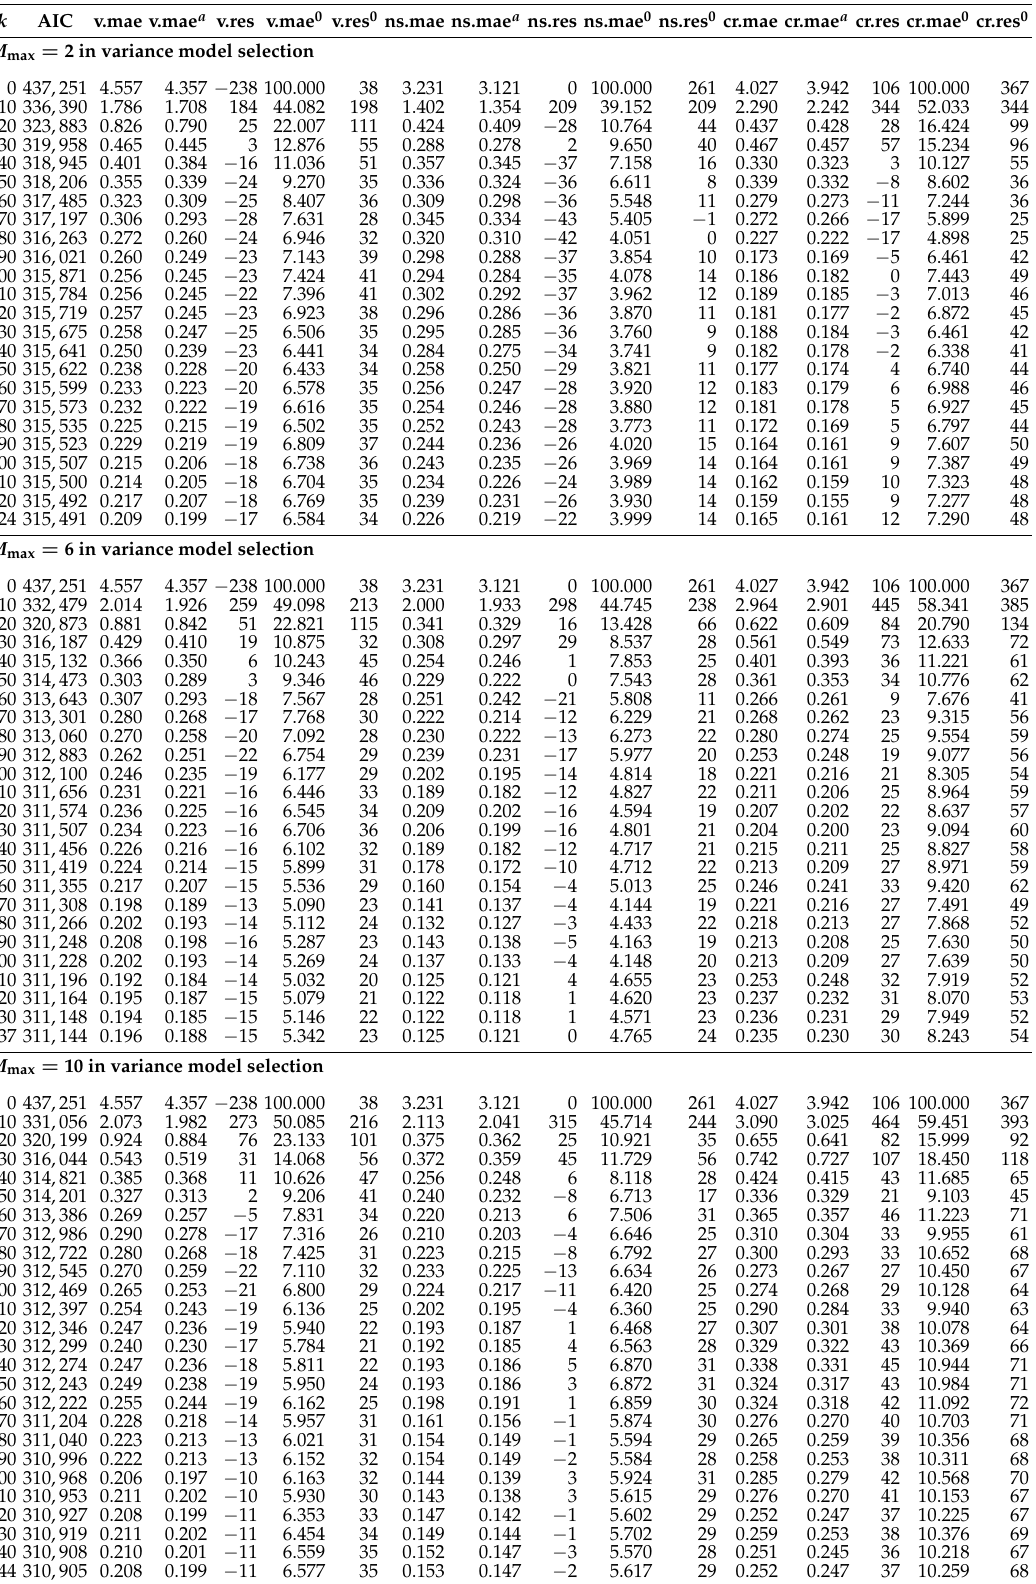
Table A29. AIC scores and out-of-sample validation figures of type II FGLS proxy functions of BEL under 300–886 with variance models of varying complexity M max after each tenth and the final iteration. k M max = 2 in variance model